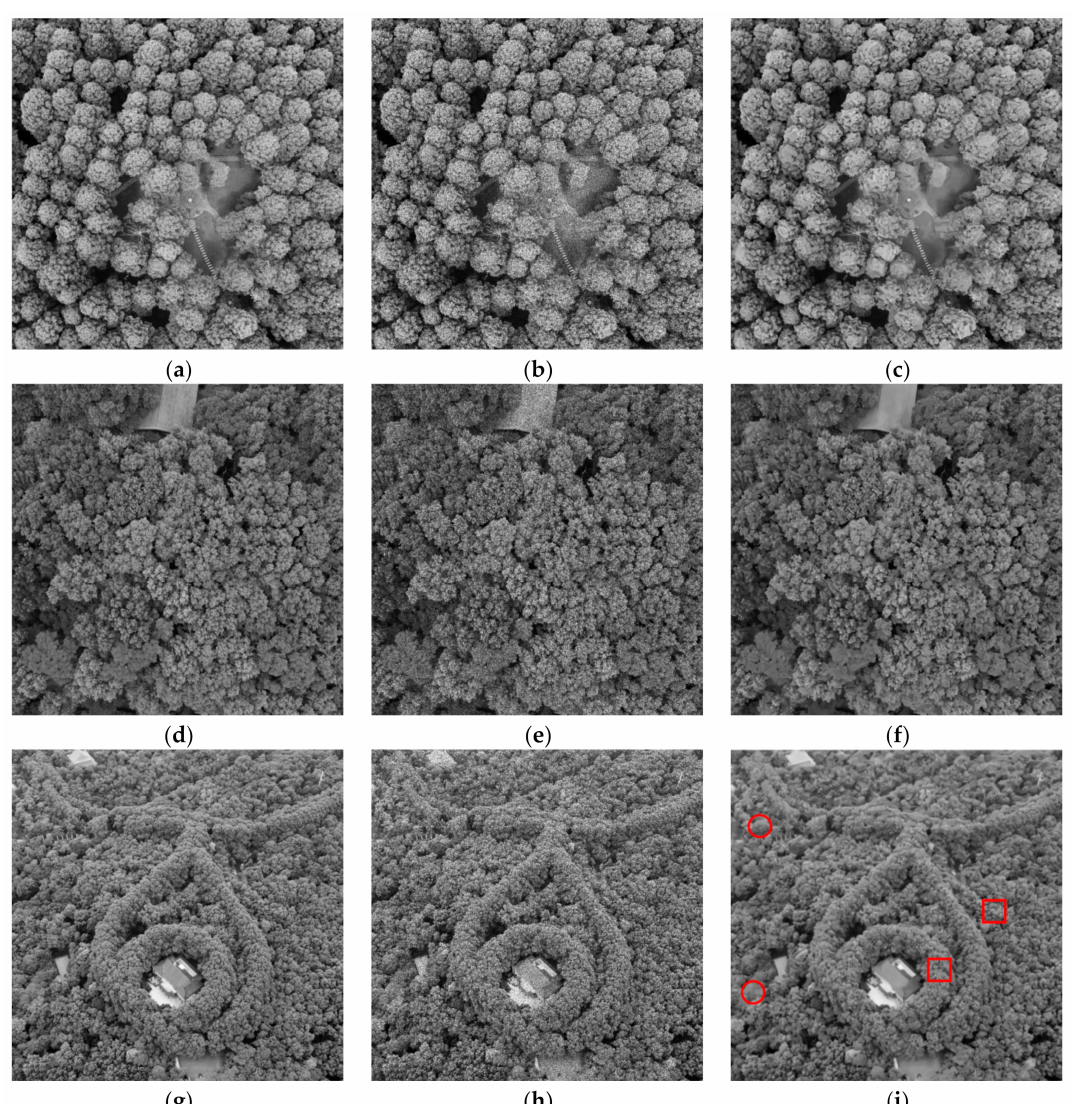
Figure 12. Three forest aerial images were chosen as the experimental objects to analyze the performance of our deep learning method. ( a ) The original image of the pure coniferous forest comprising Metasequoia glyptostroboides in Nanjing University of Science and Technology. ( d ) The original image of the broad-leaved forest near the bandstand of Sun Yat-sen Mausoleum in Nanjing city. ( g ) The original image of the conifer broad-leaved mixed forest of Sun Yat-sen Mausoleum Meiling Palace in Nanjing city. ( b , e , h ) The corresponding noisy images. ( c , f , i ) The corresponding denoising results of our